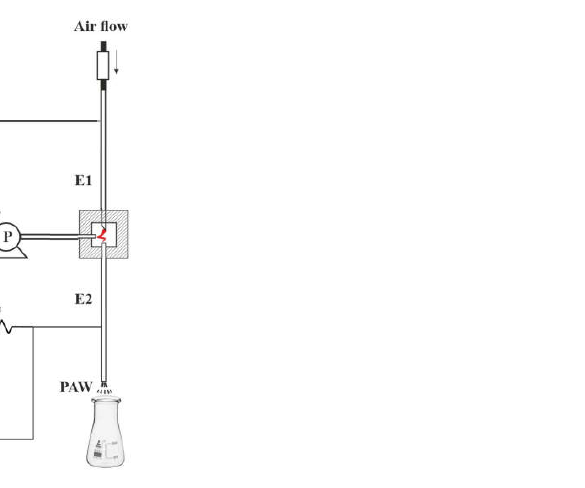
Figure 1. The experimental setup of the non-thermal plasma system: HVPS–High voltage power supply, HVP–High voltage probe, P-pump, PAW–Plasma activated water, E1–High voltage elec- trode, E2–Ground electrode, R SH– shunt. Table 1. Electrical and chemical parameters of the PAW treatment variants. Table 1. Electrical and chemical parameters of the PAW treatment